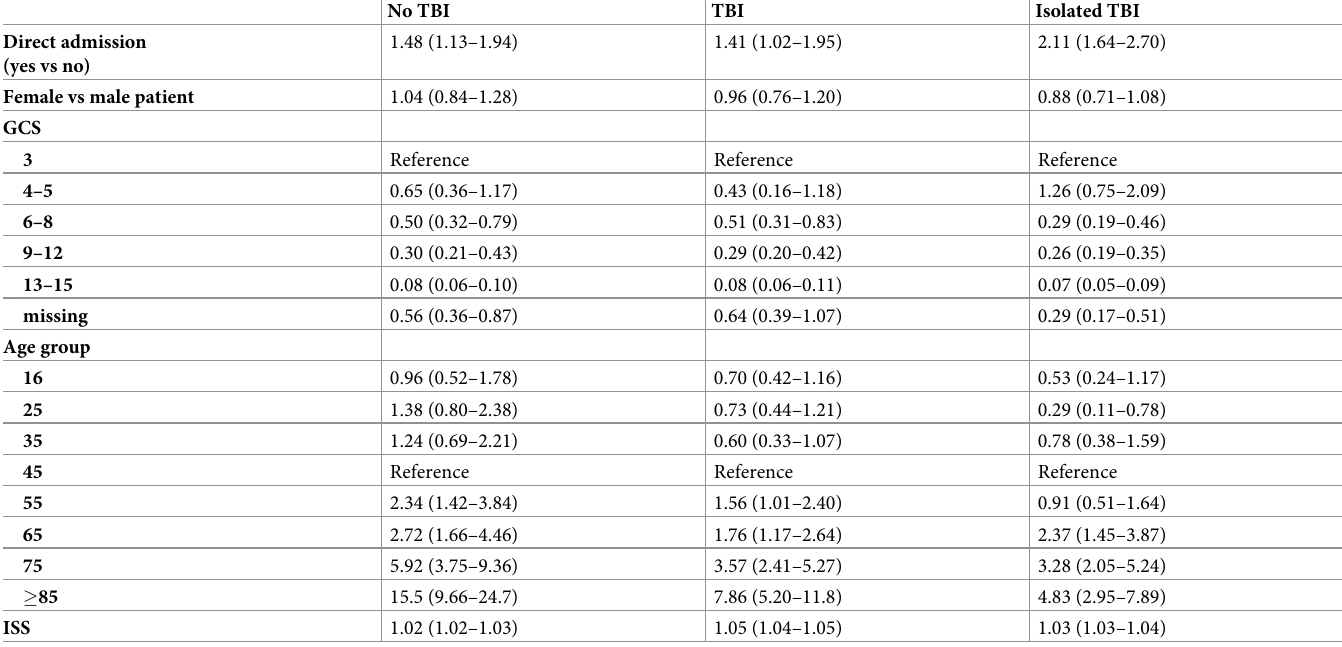
Table 4. HR for death from separate Cox proportional hazards models by injury